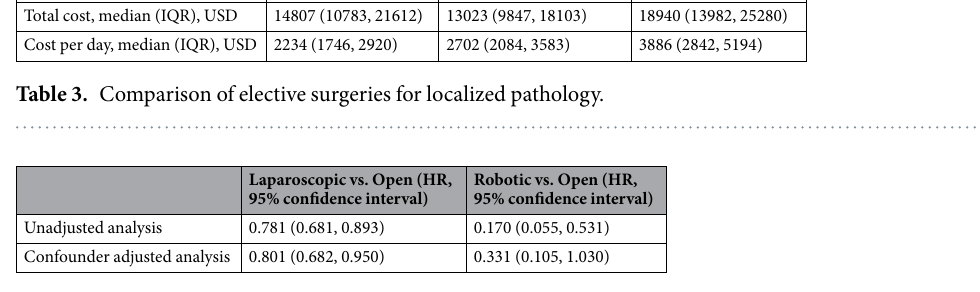
Table 4. Risk of mortality associated with the different surgeries before and after confounder